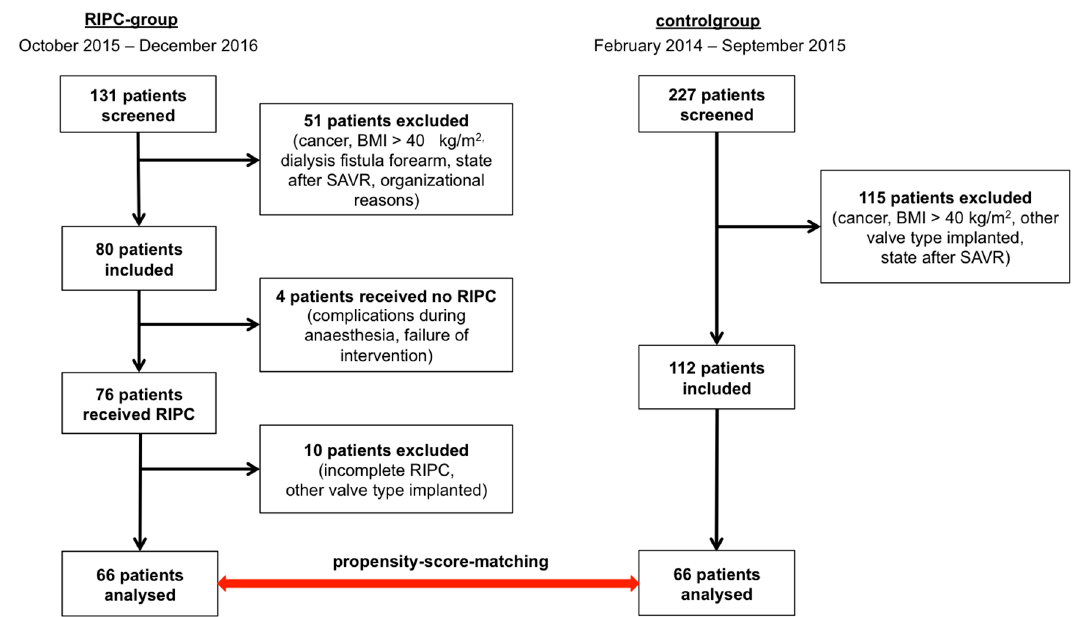
Figure 1. Study design and patient enrolment. Left column shows RIPC-group, right column shows control group. Exclusion criteria were participation in other trials, body mass index (BMI) > 40 kg/m 2 , second intervention because of bioprothesis degeneration (“ valve-in-valve ”), active malignancy with life-expectancy less than 1 year, SIRS or sepsis, cardiogenic shock, dependency on inotropes, peripheral artery disease, thrombosis and chronic renal failure with need for dialysis and dialysis fistula at forearm. BMI = body mass index; SAVR = surgical aortic valve replacement; RIPC = remote ischemic preconditioning. J. Clin. Med. 2020 , 9 , x FOR PEER REVIEW